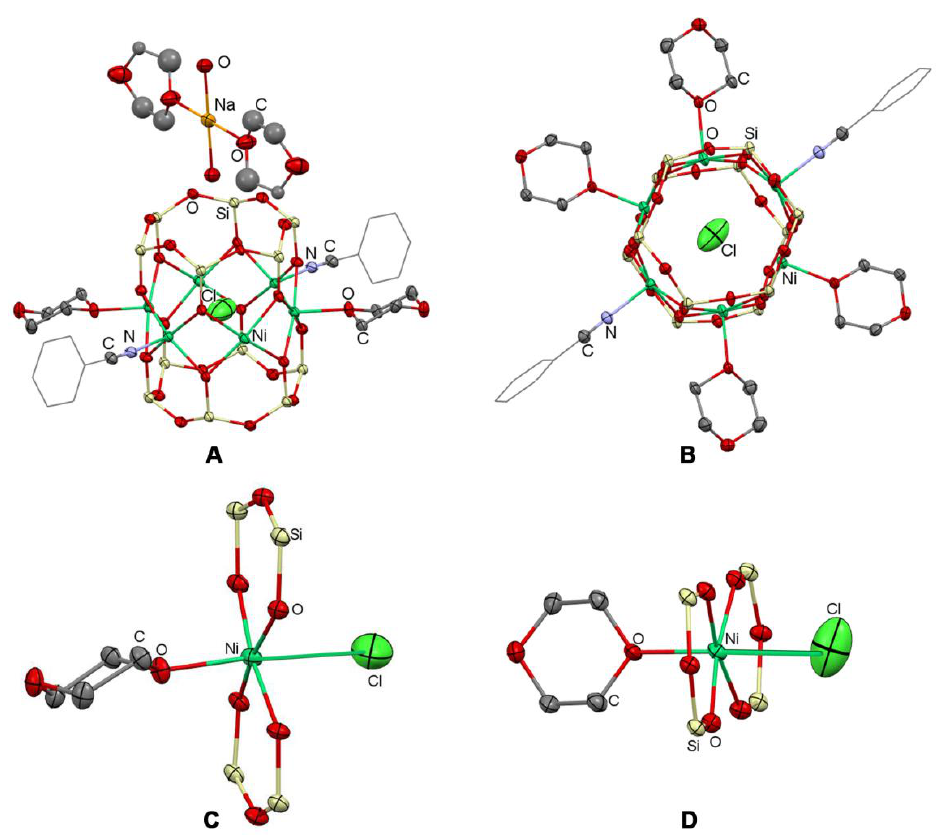
Figure 2. Structures A and B : compound 1 with solvating ligands (side and top views, respectively). Figure 2 Ph groups at silicon atoms are omitted for clarity; structures C and D is the illustration of distorted octahedral coordination of nickel ion. The anion Cl - and the oxygen atom of the coordinated dioxane molecule occupy an axial position, while the oxygen atoms of siloxanolate cycles form the equatorial plane of the coordinating